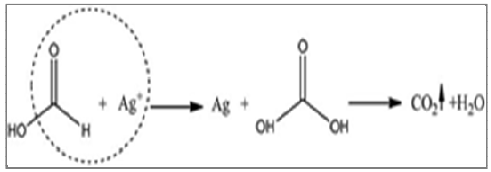
Fig. 1. Chemical mechanism of silver reduction by formic acid